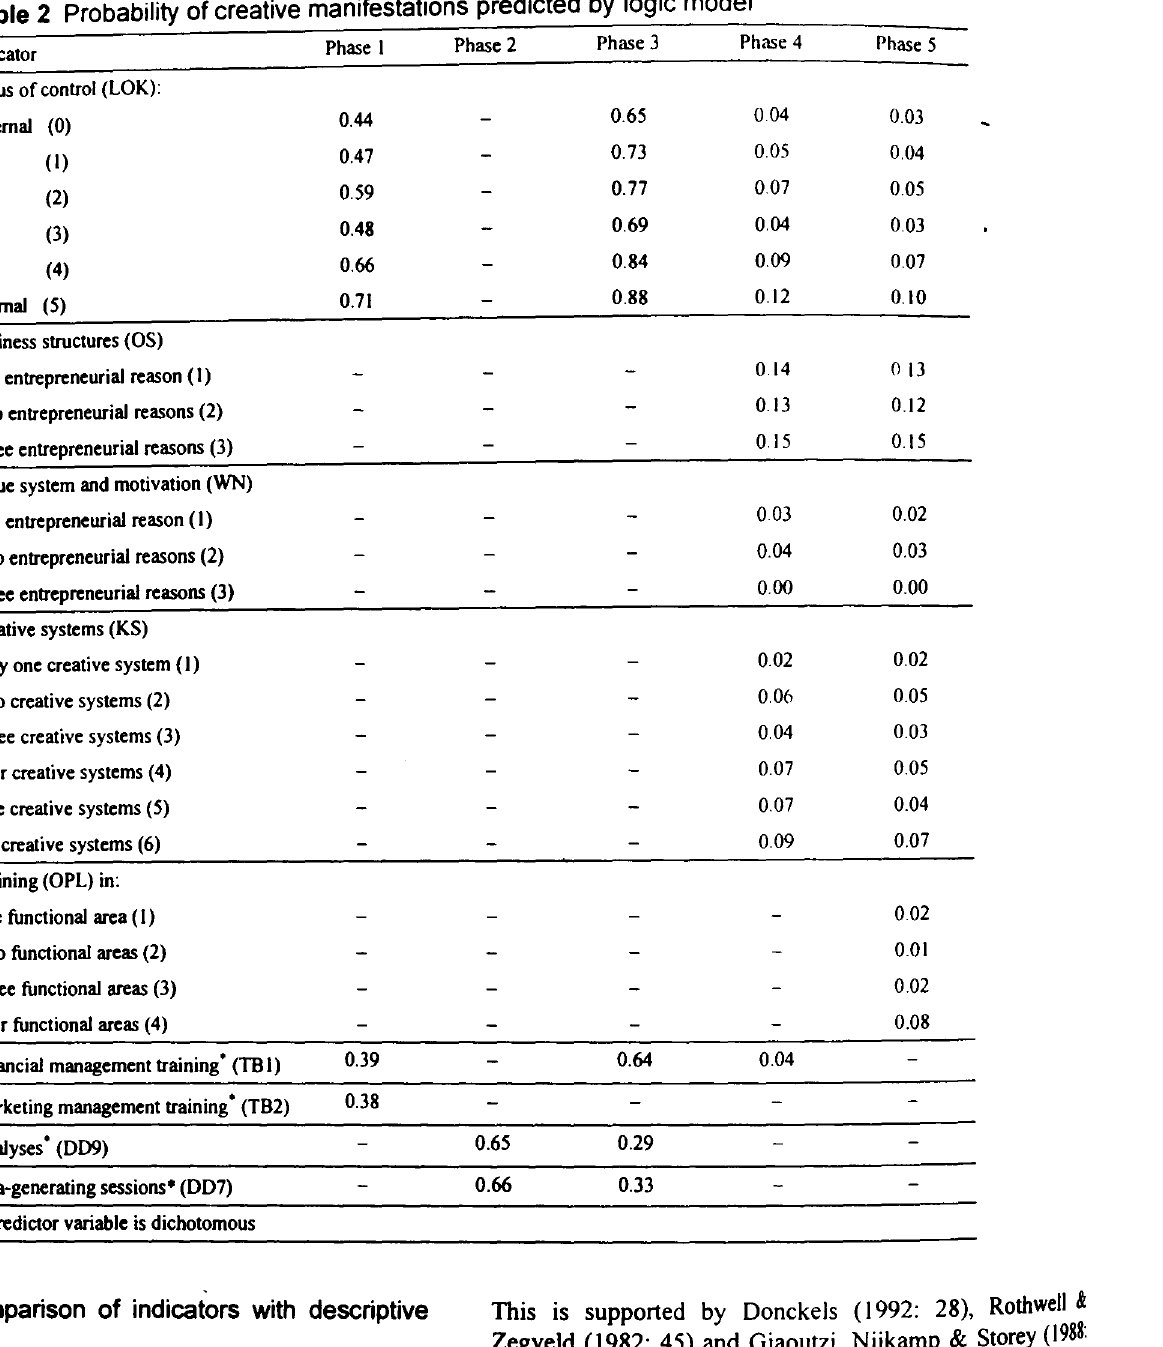
Table 3 Comparison of indicators with descriptive